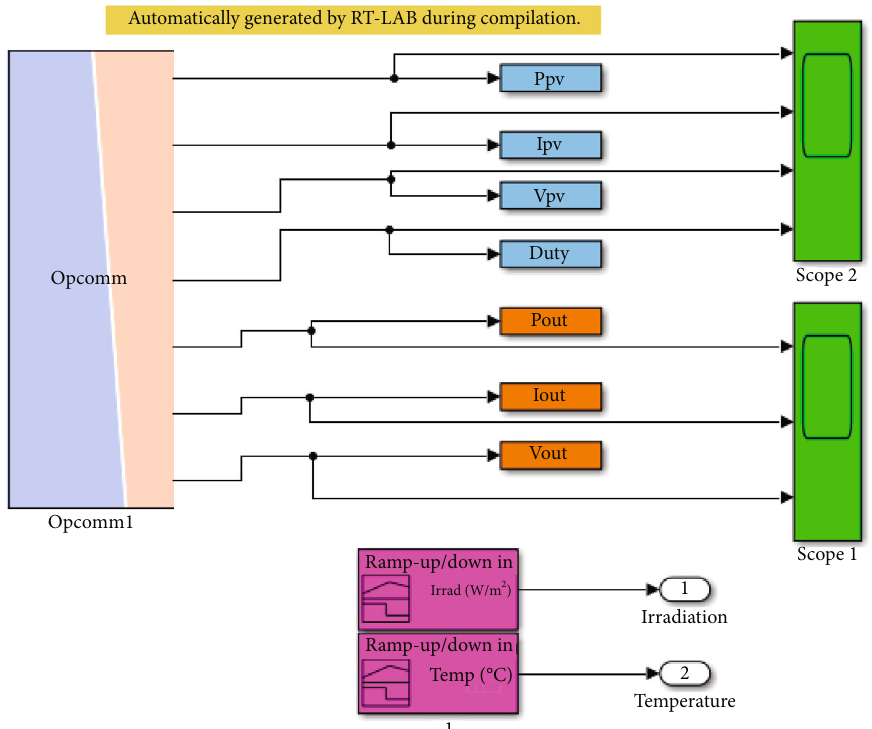
generated by RT-LAB during compilation.